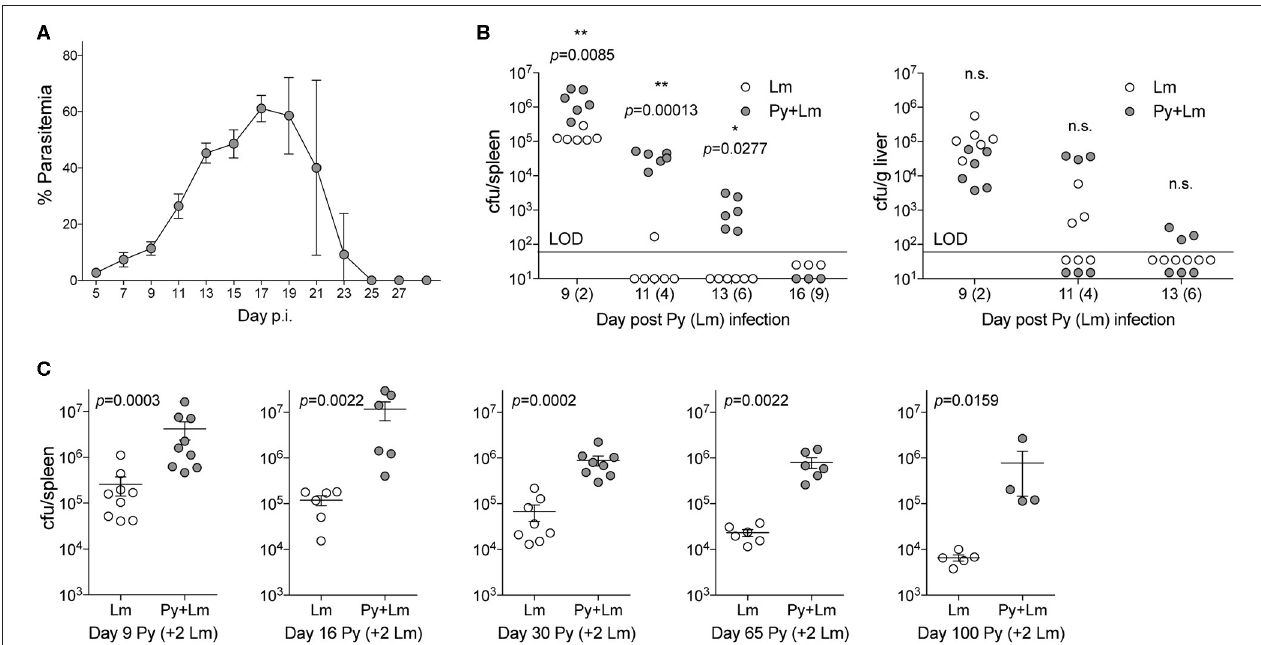
FIGURE 1 | P. yoelii infection induces long-term suppression of anti-bacterial innate immunity during bacteremia. (A) C57BL/6N mice were infected with 10 5 Py pRBCs. Percent parasitemia (percent of RBCs infected with Py) was evaluated during the course of infection. Data (mean ± S.D.) are from nine mice and representative of three independent experiments. (B) C57BL/6N mice were infected with 10 5 Py pRBCs, 7 days later both control and Py-infected mice were infected with 5 × 10 6 CFU Lm. Lm burden was determined in the spleen and liver on days 2, 3, 6, and 9 post-Lm infection. Data are cumulative results from two-independent experiments with three or six mice per group per time point. Each symbol represents an individual mouse. Data were analyzed by two-tailed Fisher’s exact test. LOD, limit of detection. [cfu/spleen day 11 ( White et al., 2015) data was originally published in The Journal of Immunology . White C.E., Villarino N.F., Sloan S.S., Ganusov V.V., and Schmidt N.W. 2015. Plasmodium Suppresses Expansion of T Cell Responses to Heterologous Infections. J. Immunol. 194: 697-708. Copyright © 2015 The American Association of Immunologists, Inc.] (C) C57BL/6N mice were infected with 10 5 Py pRBCs. On days 7, 14, 28, 63, and 98 post-Py infection both Py-infected and control mice were infected with 5 × 10 6 CFU Lm. Bacterial burdens were determined 2 days post Lm infection. Data (mean ± S.E.) are cumulative results from 2- to 3-independent experiments with 4–9 mice per group. Data were analyzed with Mann-Whitney test, n.s., not